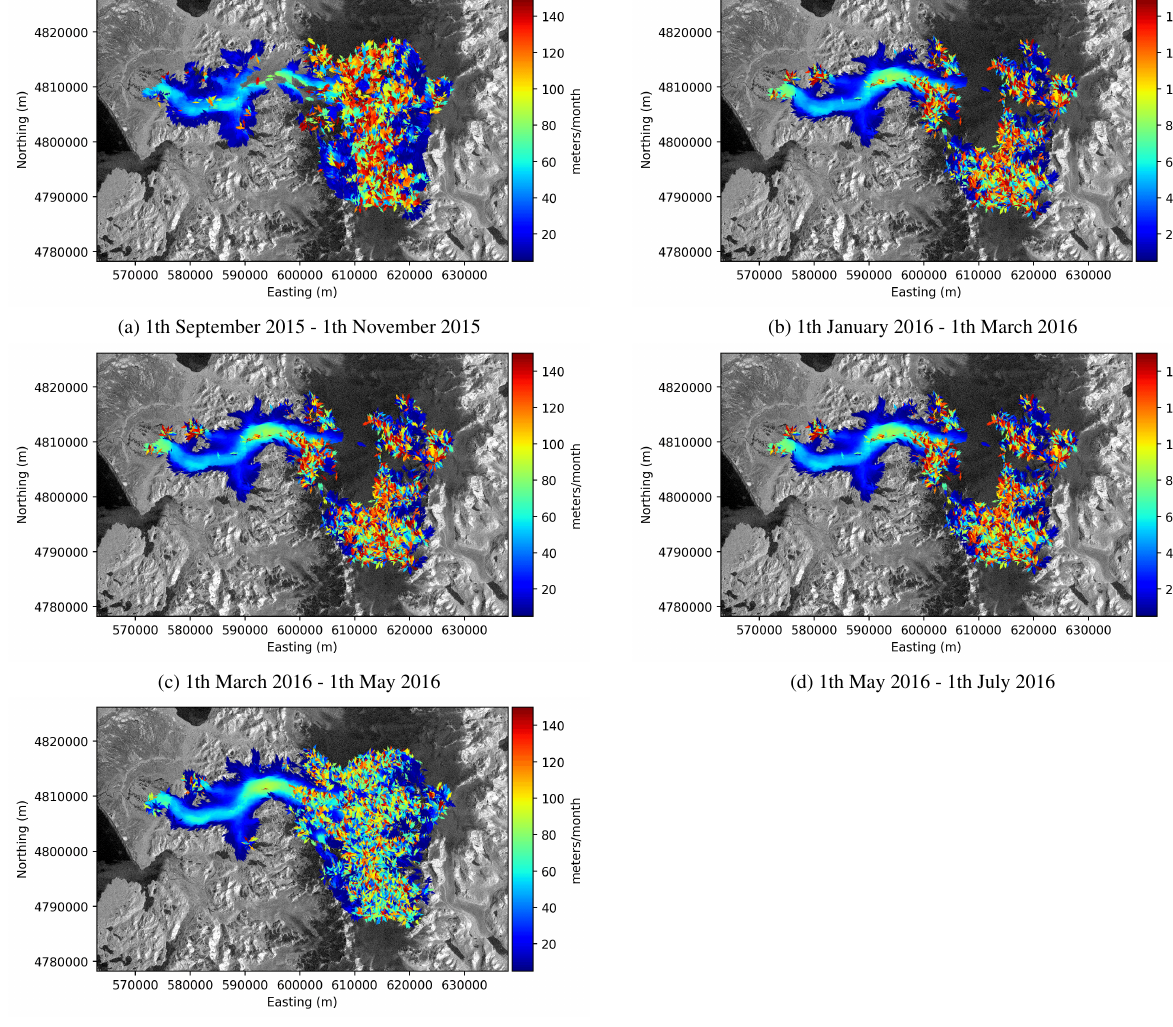
Figure 6. Temporal series of San Quintin Glacier surface velocity